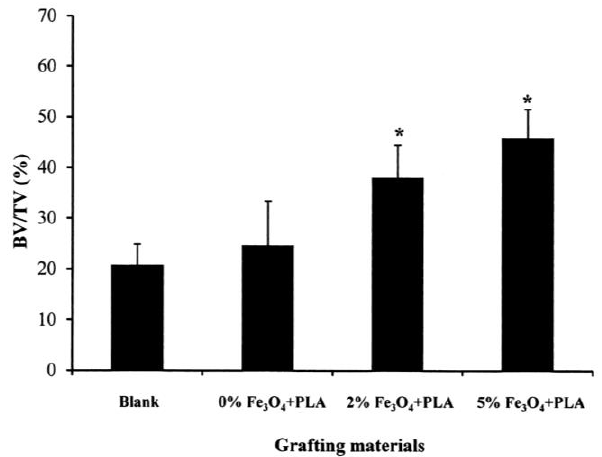
Figure 7. BV/TV% values for artificial bony defects filled with blank, neat PLLA and Fe 3 O 4 /PLLA nanofibers after eight weeks (* p < 0.05).